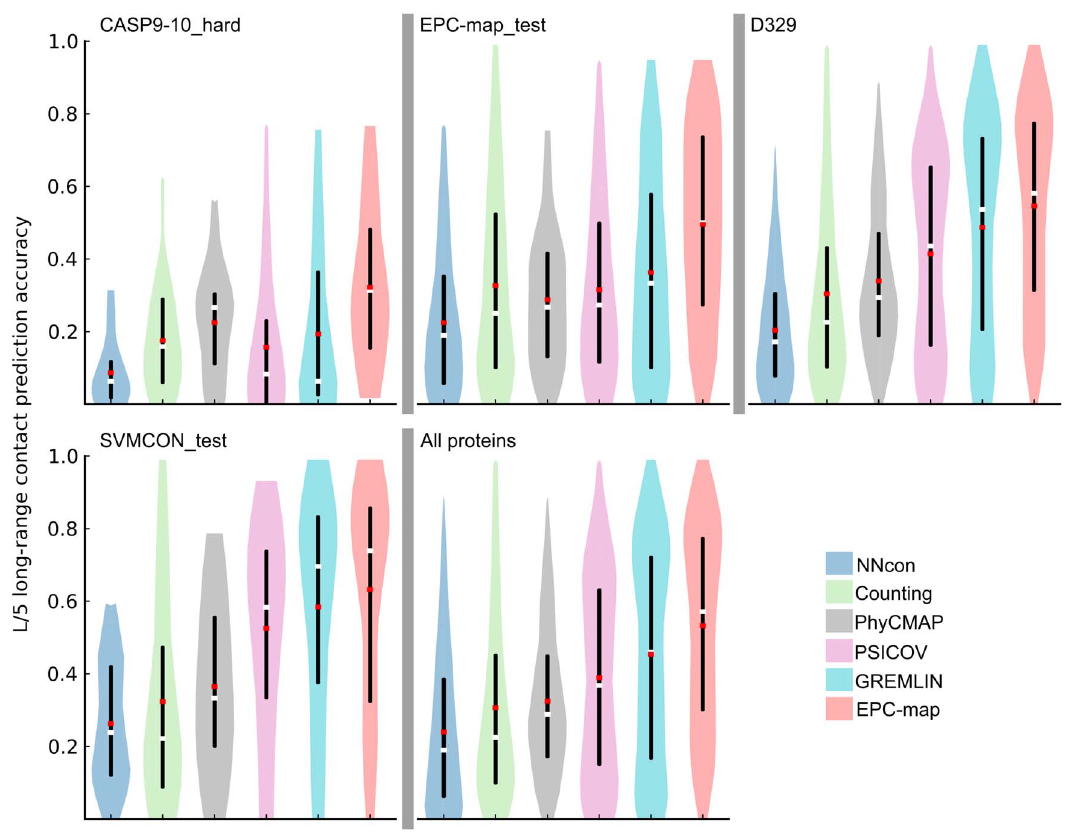
Figure 4. Prediction performance overview for the CASP9-10_hard, EPC-map_test, D329 and SVMCON_test data sets. The figure shows the long-range contact prediction performance of the top scoring L/5 contacts. Different methods are shown as color coded violin plots. The lower and upper end of the black vertical bars in each violin denote the accuracy at the 25 and 75 percentile, respectively. White horizontal bars indicate the median, red horizontal bars the mean accuracy. The distribution of the prediction accuracies for individual proteins is indicated by the shape of the violin. Data sets are sorted from difficult (CASP9-10_hard) to easy (SVMCON_test). The last panel shows the pooled results for all proteins from these data sets.